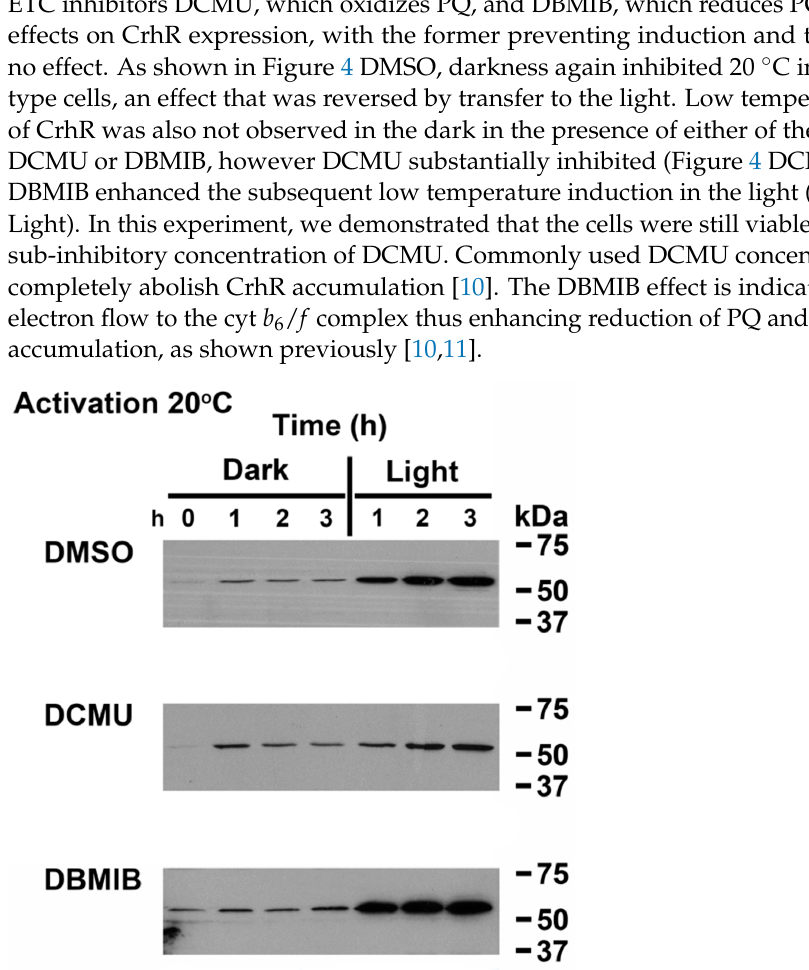
Figure 4. Absence of ETC reduction generates the dark effects. Wild type Synechocystis cells were grown to mid-log phase at 30 °C and the effect of dark-light transition associated with stresses that alter the ETC redox potential on CrhR accumulation was analyzed by Western blotting. Wild type Synechocystis cells grown at 30 °C under standard light conditions (T = 0) were transferred to 20 °C in the dark for 3 h after addition of DMSO, DCMU or DBMIB. Cells were then returned to growth light for 3 h. Cells were sampled at indicated times. CrhR protein abundance was determined by Western blotting, as described in Figure 1.